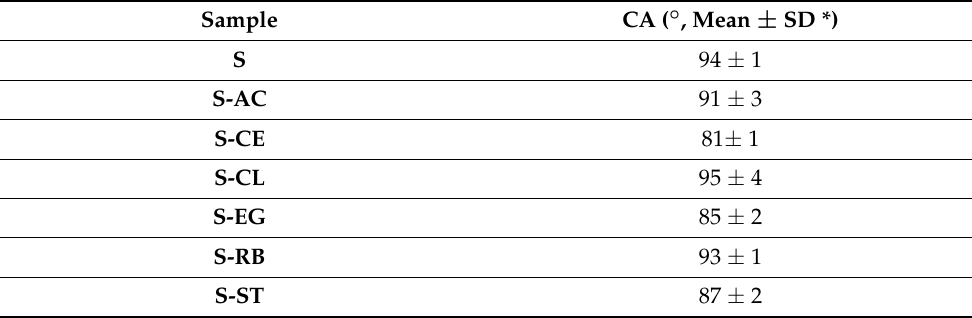
Table 1. Water contact angle (CA) values (in ◦ ) of the cured coatings on AA3003 substrate.